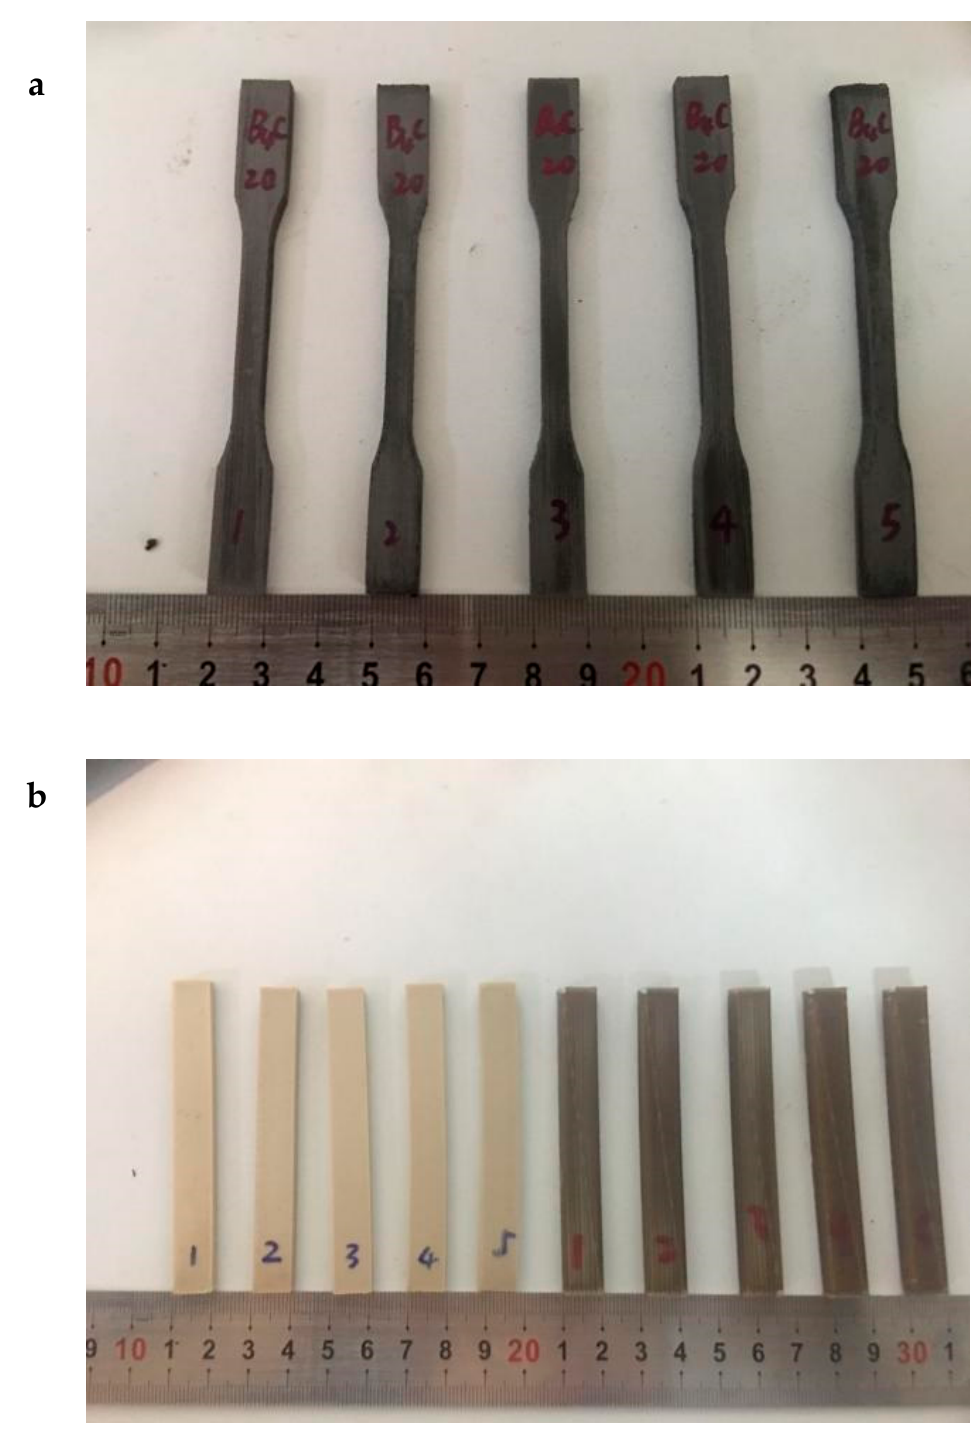
Figure 8. Mechanical properties of test pieces: ( a ) tensile strength test pieces and ( b ) flexural strength test pieces.